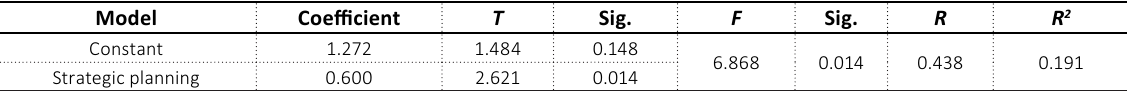
Table 7. The impact of strategic planning on the internal business process perspective